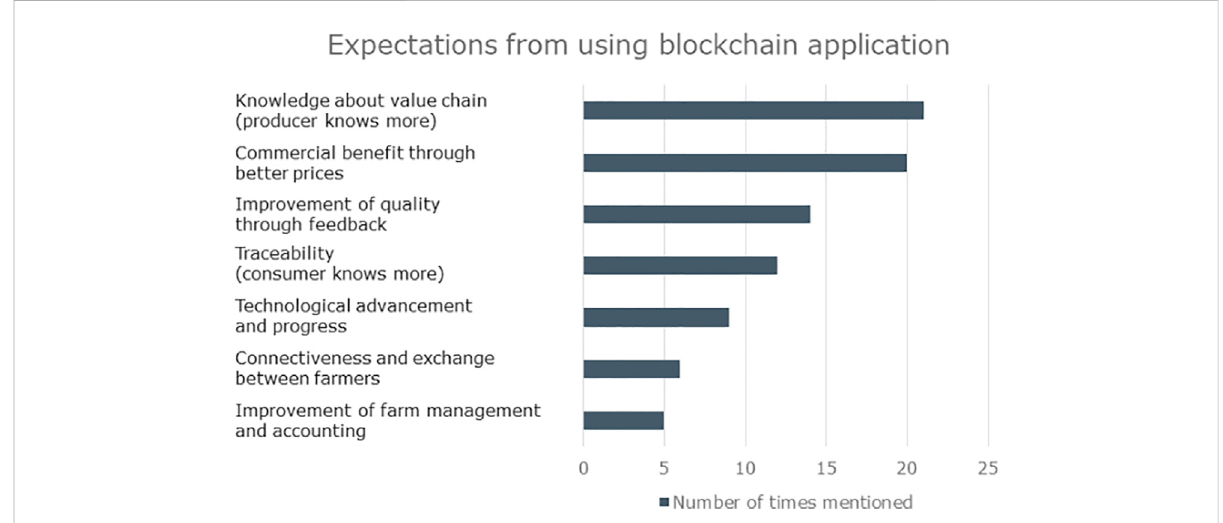
Expectations associated with the positive attitude towards innovation. Learning more about the coffee value chain has been mentioned 21times,commercialbene fi